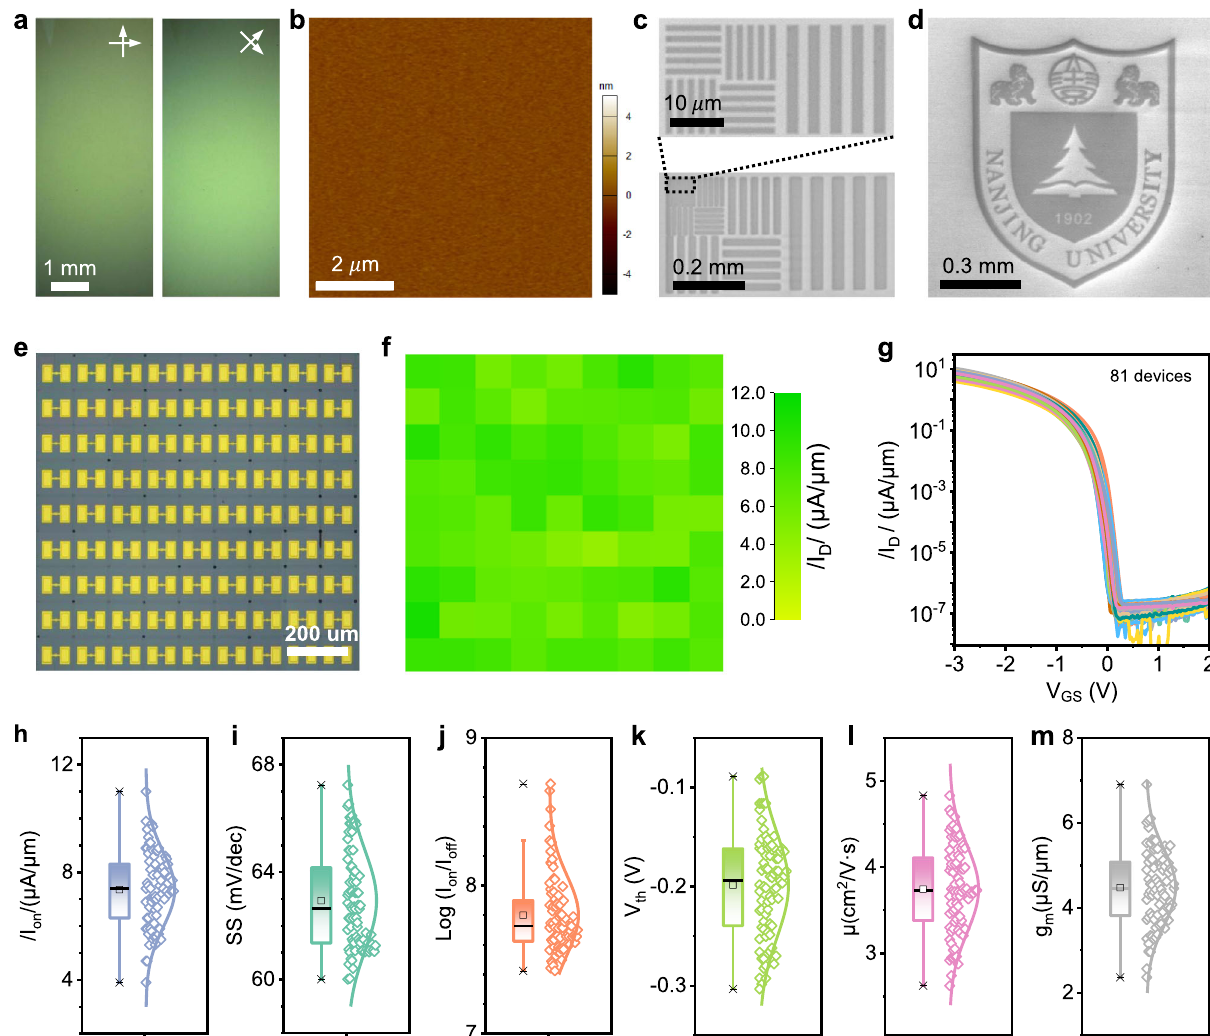
Fig. 5| C 10 -DNTT OTFTarrayperformance.a Cross-polarizedoptical microscopy ofuniformmonolayerC 10 -DNTTsinglecrystal,showingasinglecrystalexceptfora smallportionatthetop. b AtomicforcemicroscopyimageofmonolayerC 10 -DNTT fi lms. c , d Scanning electron micrograph of electron-beam generated line and NJU logo pattern of monolayer C 10 -DNTT fi lm, respectively. The blackened area is irradiatedbytheelectronbeam. e Photographofafabricated9×9OFETarraywith